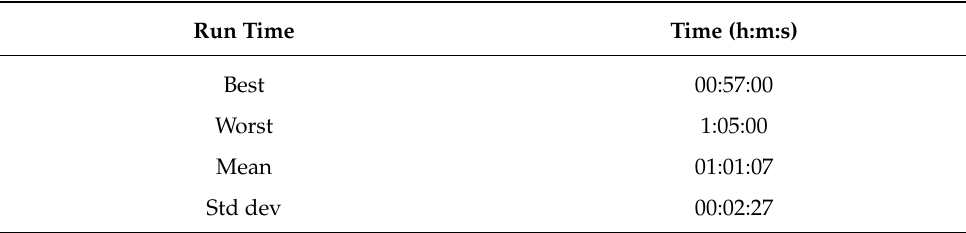
Table 8. Experiments measures: running time for Scenario Scenario A3—Hyperband.